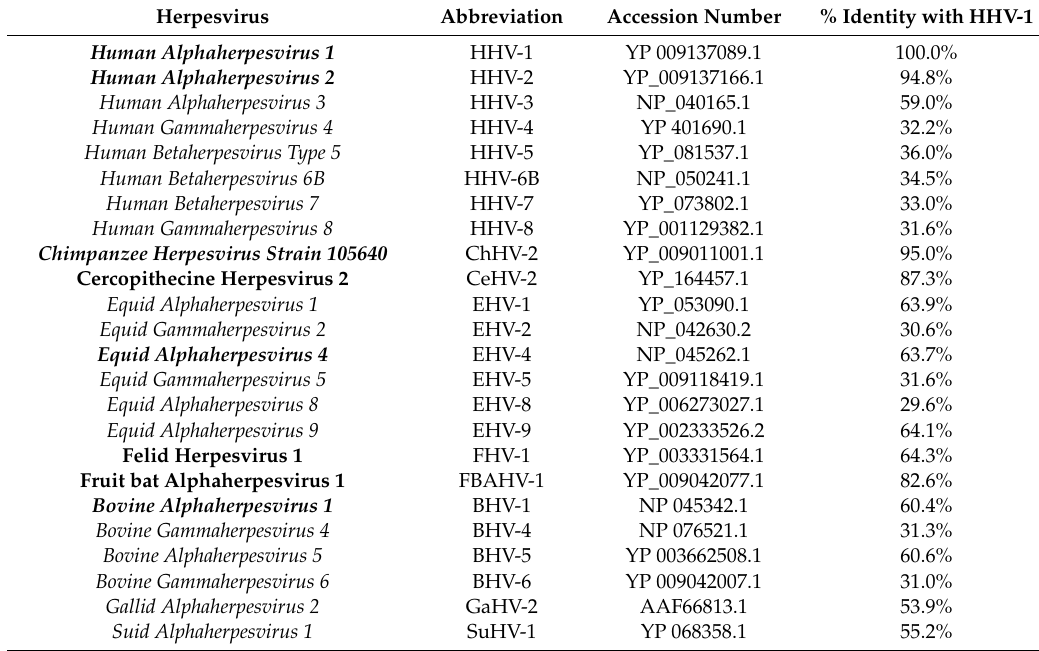
Table 1. Herpesvirus pUL15 orthologs analyzed in this study. Species in bold were used to estimate the rate of change, whereas those in italics were used to construct the phylogenetic